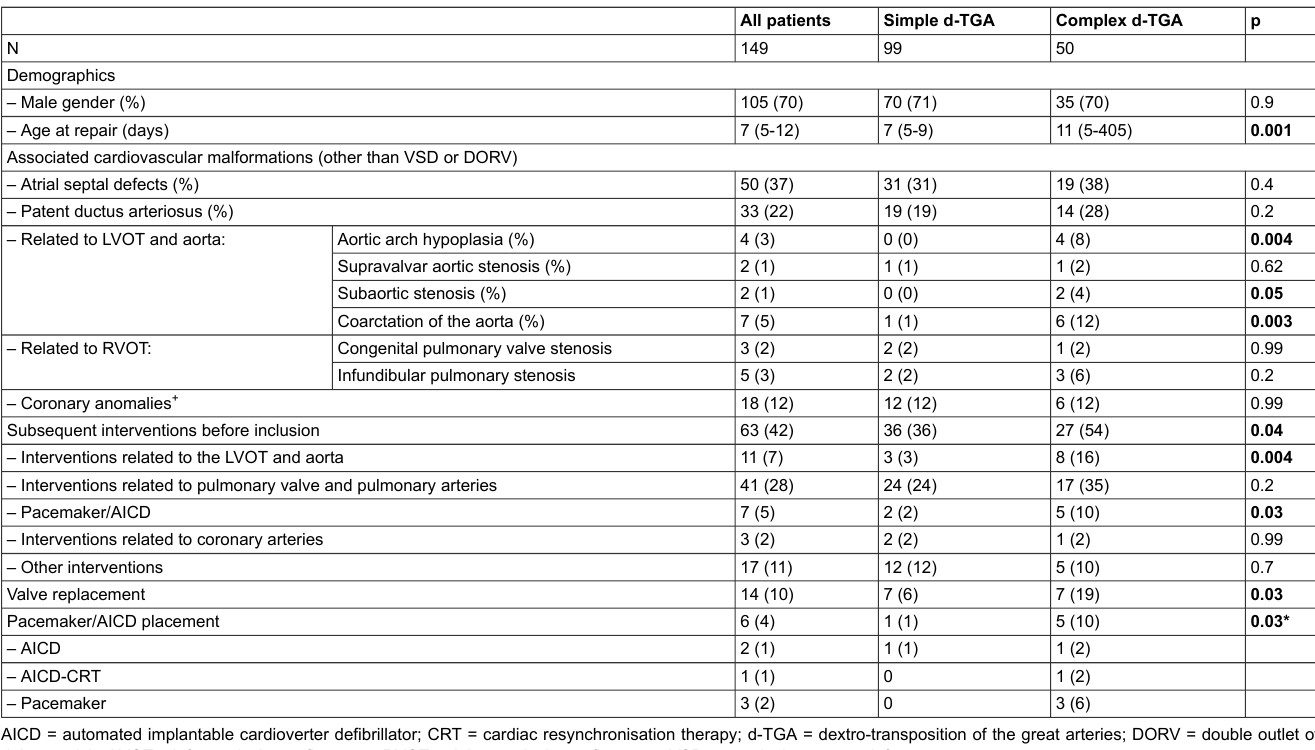
Table 1: Baseline characteristics.